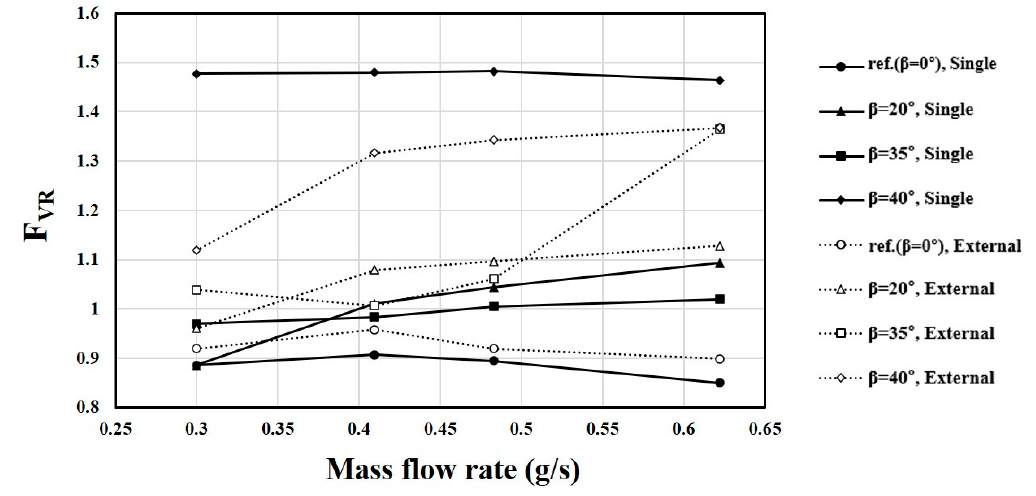
Figure 14. Comparison of peak velocity ratio variation with mass flow rate between the cases with and without external flow for various bending angles.